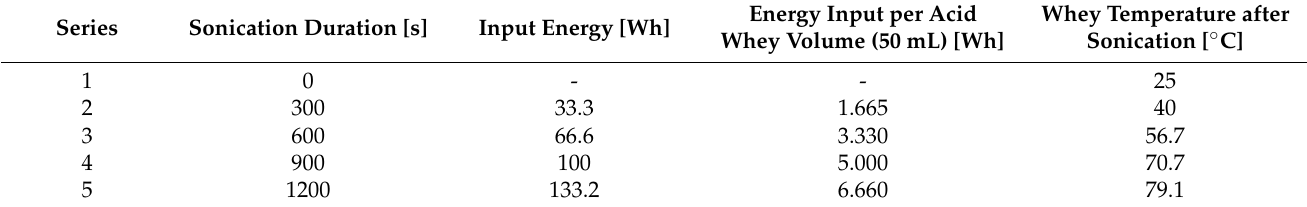
Table 1. Experimental design.